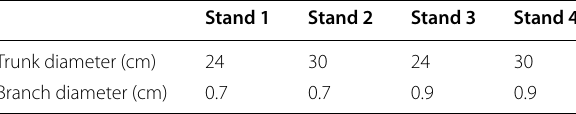
Table 3 Diameters of the 4 aspen